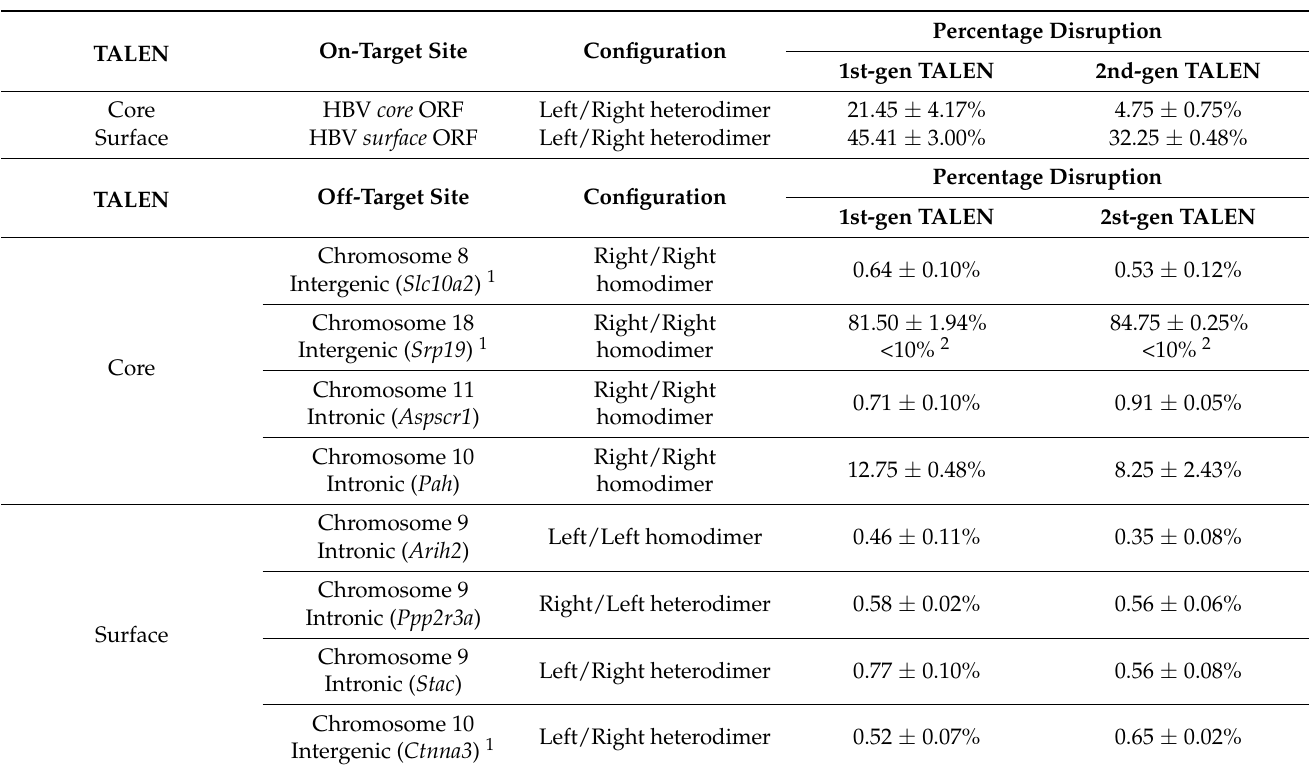
Table 1. Targeted amplicon next-generation sequencing results of on-target and potential off-target sites of the anti-HBV C and S TALENs.